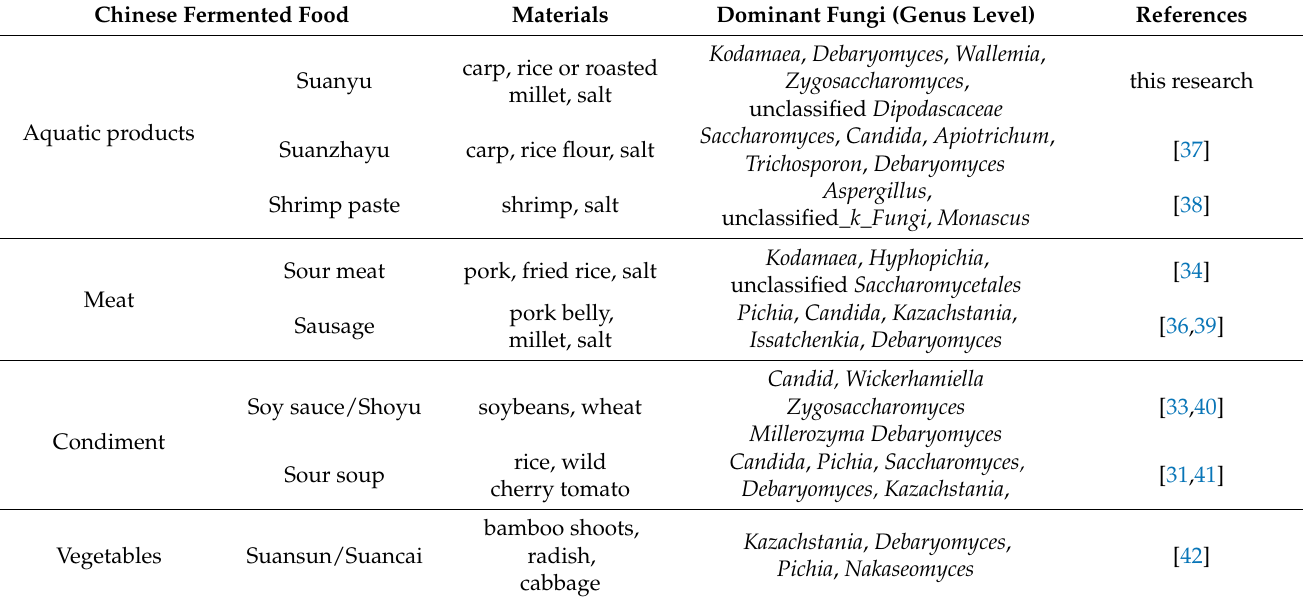
Table 5. Comparison of Suanyu with other Chinese traditional fermented foods. Chinese Fermented Food Materials Dominant Fungi (Genus